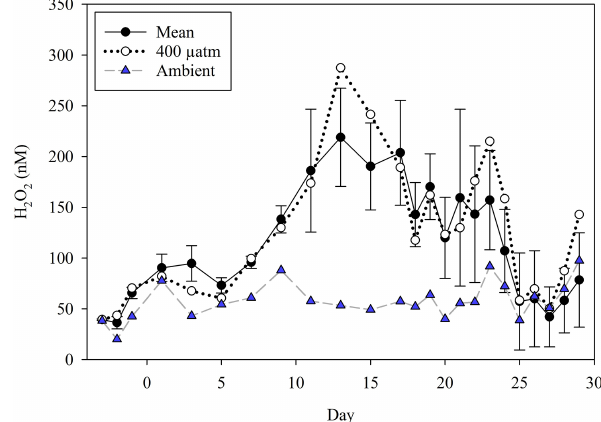
Figure 1. A summary of H 2 O 2 over the duration of a p CO 2 gradi- ent mesocosm in Gran Canaria. Data from Hopwood et al. (2018). The mean ( ± SD) H 2 O 2 from all p CO 2 treatments is contrasted with the concentration in ambient surface seawater immediately outside the mesocosms. In addition to its inclusion in the mean, the baseline 400µatm p CO 2 treatment is shown separately to allow comparison with ambient surface